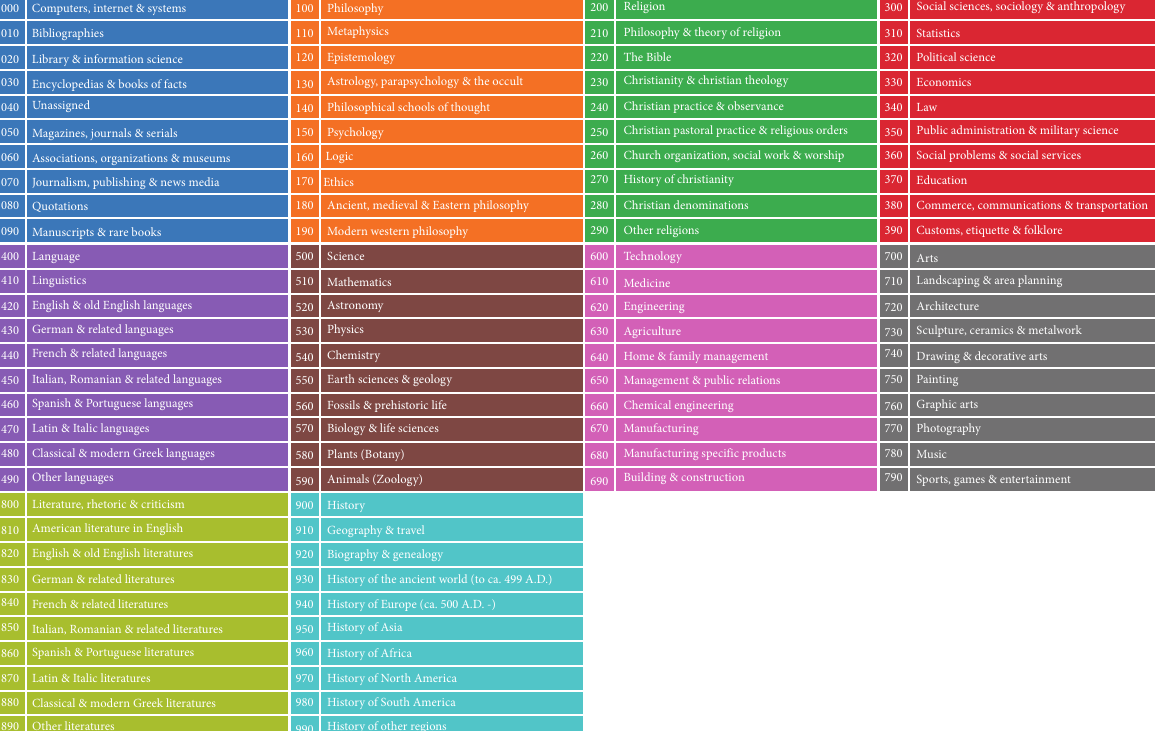
Figure 27: Color codes of the classes of the 2 nd level of the